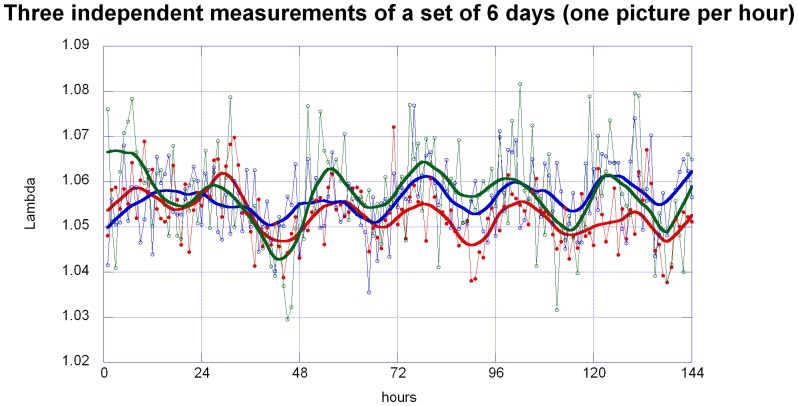
Three independent measurements of Lambda (P1, P2, P3), based on 144 pictures of the same mistletoe berry (24 pictures per day in the course of six days).P1 (red dots) and P2 (blue circles) are two independent measures by the same person, P3 (green circles) by a different person. Every data point represents the mean of several measurements (n = 10 for P1 and P3, n = 6 for P2). Error bars were omitted for clarity. The smooth continuous lines represent LOWESS fits with P = 10% (red: P1, blue: P2, green: P3).